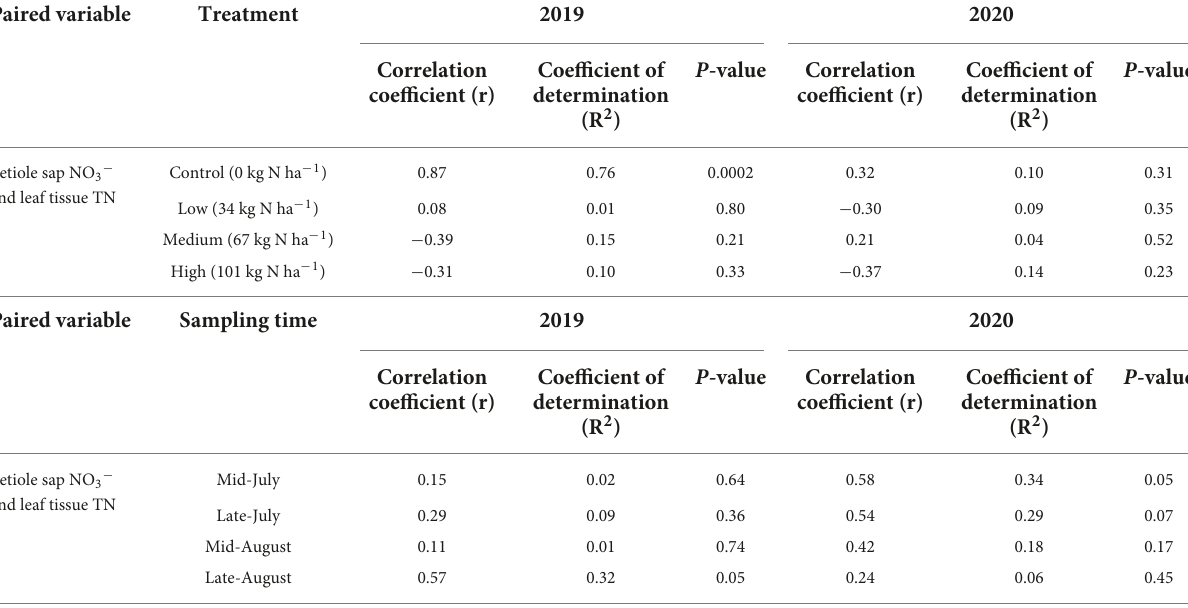
TABLE 5 Pearson correlation coefficients (r), linear regression coefficients of determination (R 2 ), and the P -values of paired variables by nitrogen fertilizer rate treatments in 2019 and 2020. Paired variable